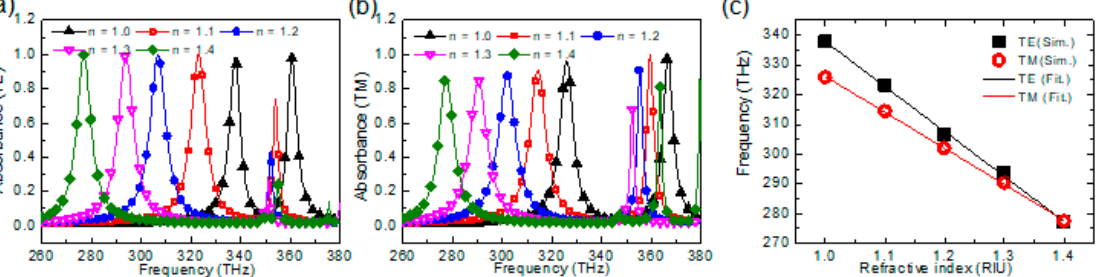
Figure 7. Absorbance spectra depending on different refractive indices ( n ) of surroundings for ( a ) TE- polarized wave and ( b ) TM-polarized wave. ( c ) Simulated (symbols) and linear fit (line) resonance frequencies as a function of n